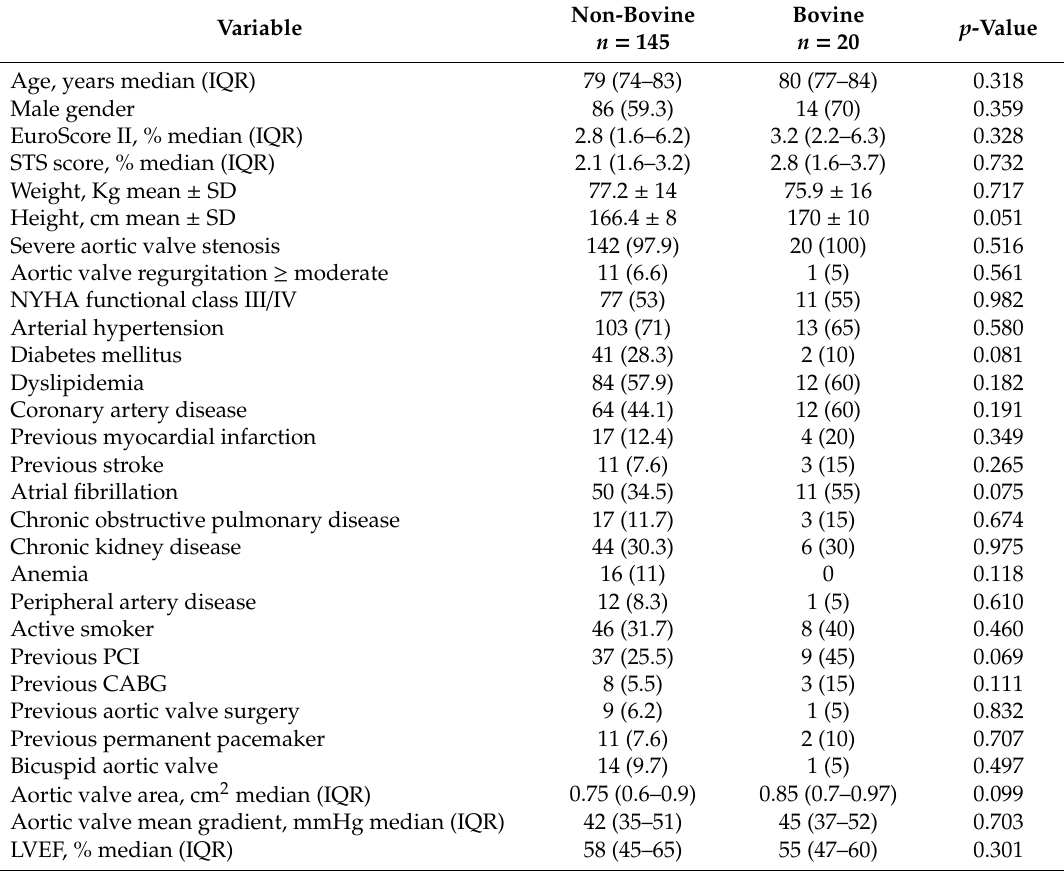
Table 1. Baseline clinical and aortic valve characteristics in patients undergoing transcatheter aortic valve replacement (TAVR) with concomitant cerebral protection.